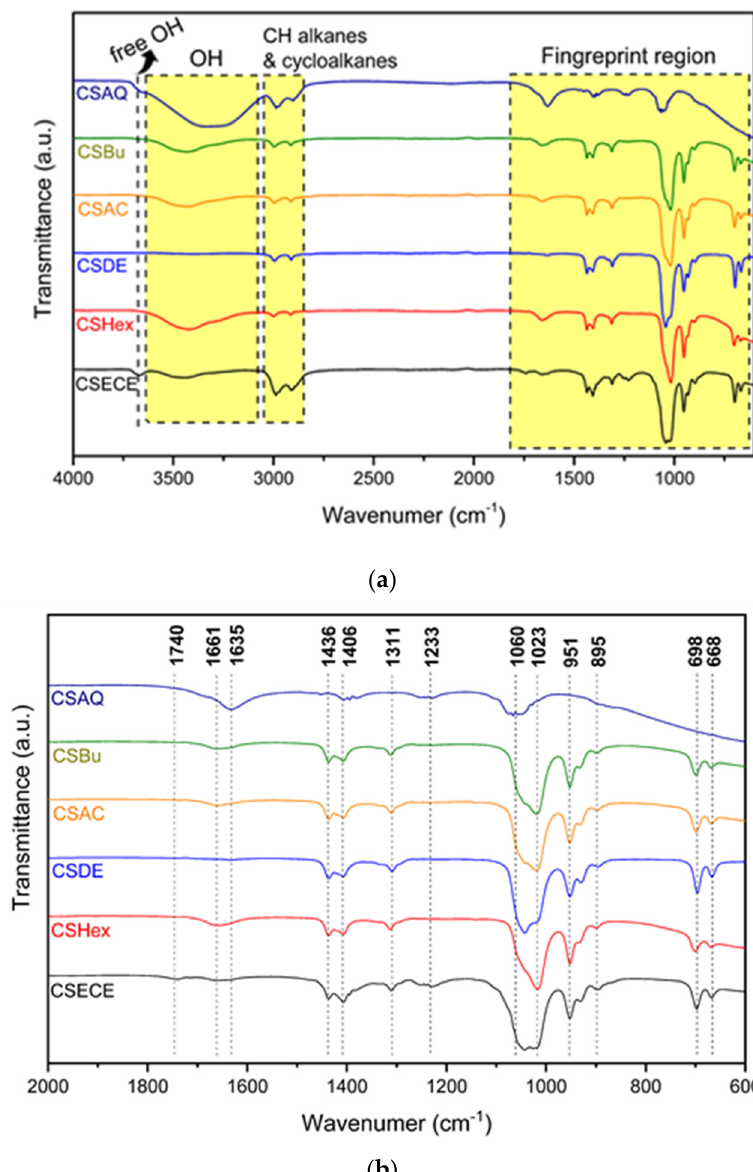
Figure 2. ( a ) FTIR spectra of crude extract and corresponding fractions obtained from Capparis spinosa L. CSECE: crude extract. The fractions: CSHex: hexane, CSDE: diethyl ether, CSAC: ethyl acetate, CSBu: n-butanol, CSAQ: aqueous. ( b ) Fingerprint region of FT-IR spectra of crude extract and fractions; CSHex: hexane, CSDE: diethyl ether, CSAC: ethyl acetate, CSBu: n-butanol, CSAQ: aqueous of Capparis spinosa L.